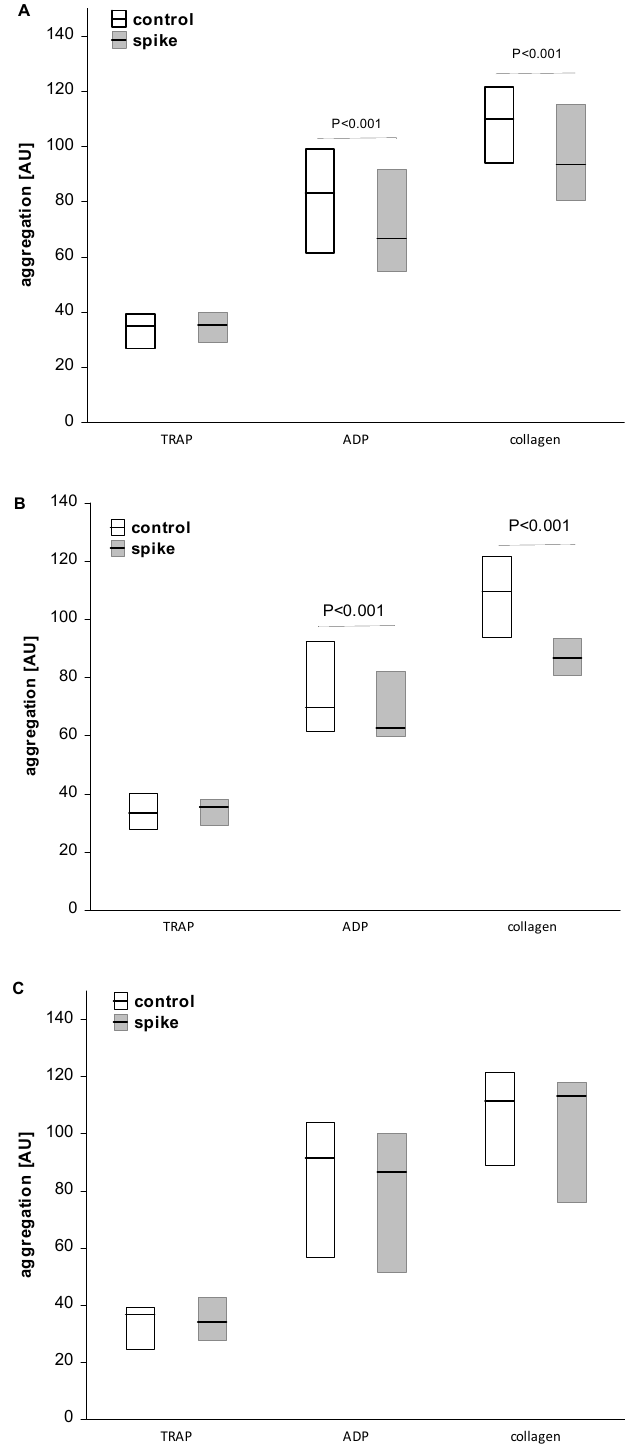
Figure 1. The effect of spike protein on platelet aggregation in whole blood. Data are shown as median and interquartile range (Q1; Q3). The analysis was performed in the total group, n = 38 ( A ), in the High Ab-group, n = 19 ( B ), and in the Low Ab-group, n = 19 ( C ). A significant reduction in the presence of spike protein was observed for ADP- or collagen-induced aggregation in all participants ( A ) and in the High Ab-group ( B ) ( p < 0.001), but not in the Low Ab-group ( C ). The statistical significance of differences between control vs. spike sample was estimated with the bootstrap-boosted paired Student’s t -test.